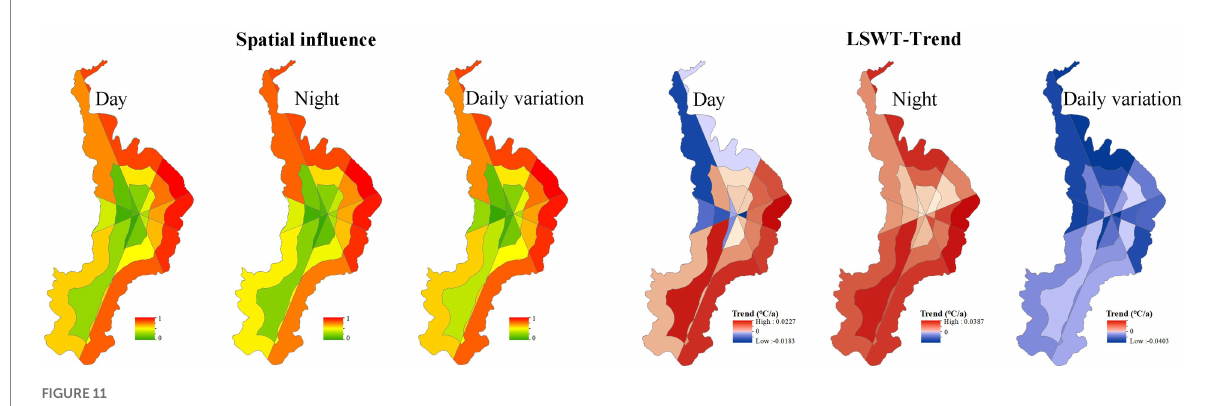
FIGURE 11 Spatial influence and LSWT trends of lake partition.